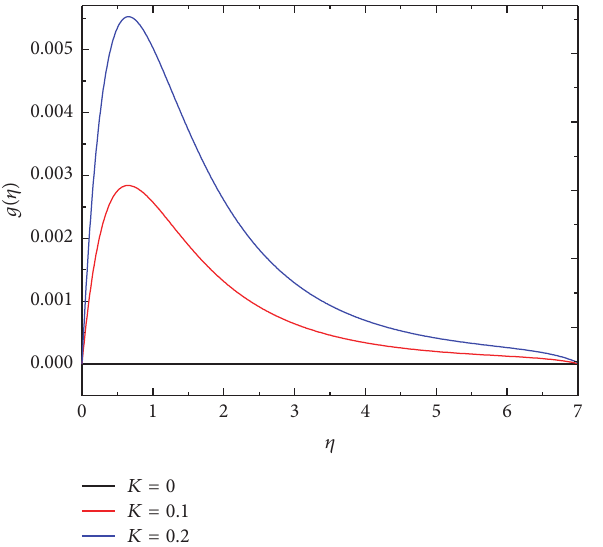
Figure 6: Microrotation profiles for various values of 𝐾 when 𝐴 = 0.4 , 𝑅 = 0.5 , and 𝜉 = 0 .